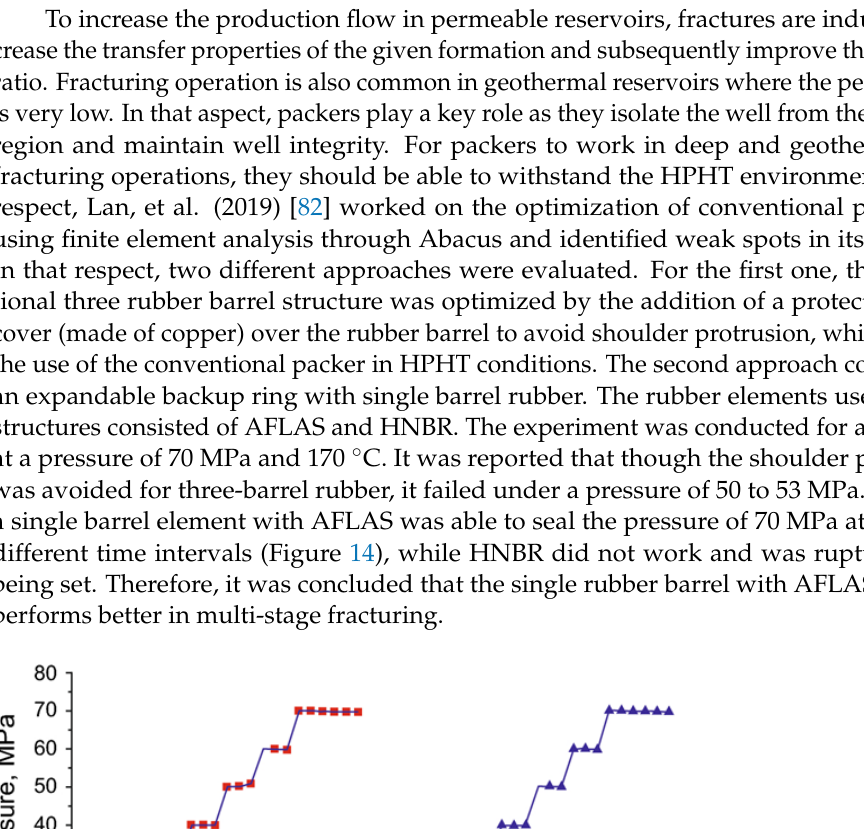
Figure 13. Open hole extreme expansion packer [82].